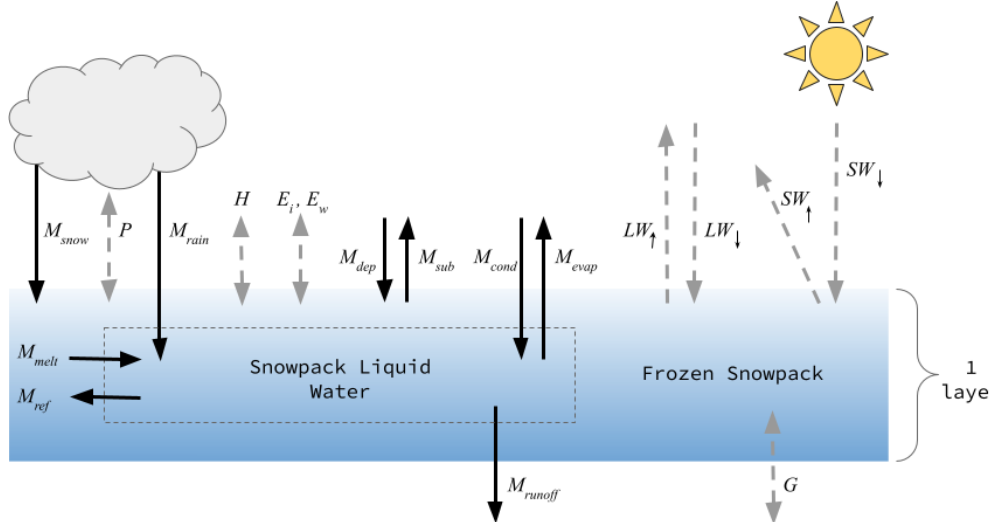
Figure 1. Snow model conceptual diagram. Solid black arrows indicate mass fluxes, and dashed grey arrows indicate energy fluxes. Fluxes are described in Sect. 2. Table 2. Parameters, their abbreviated names, the parameter values used in calibration, and their units. Additional parameter options, includ- ing the VIC model albedo option, were evaluated in preliminary work but were excluded from the full calibration due to consistently poor